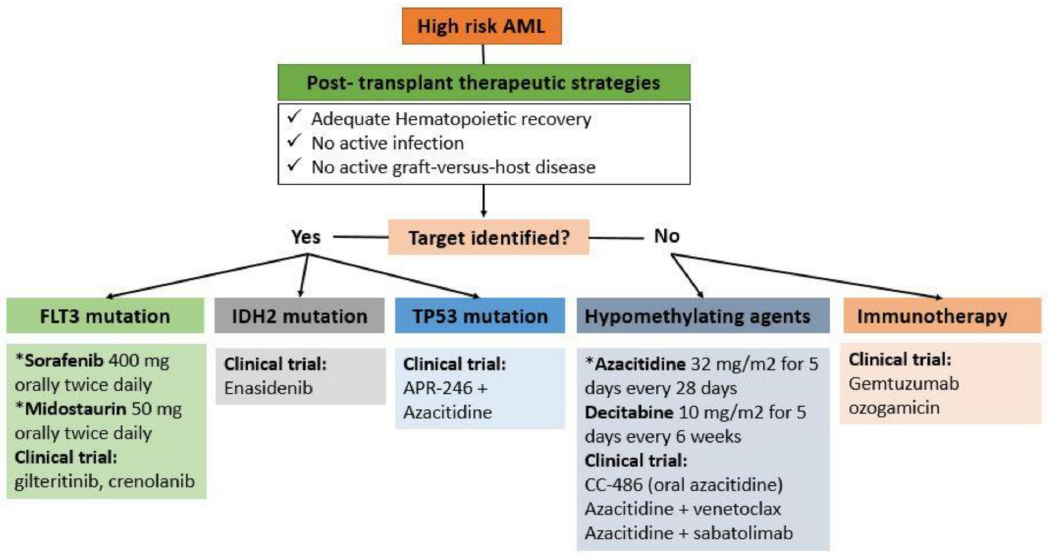
Figure 1. Therapeutic options for post-transplant maintenance in high risk AML. * recommended in clinical practice based on published clinical